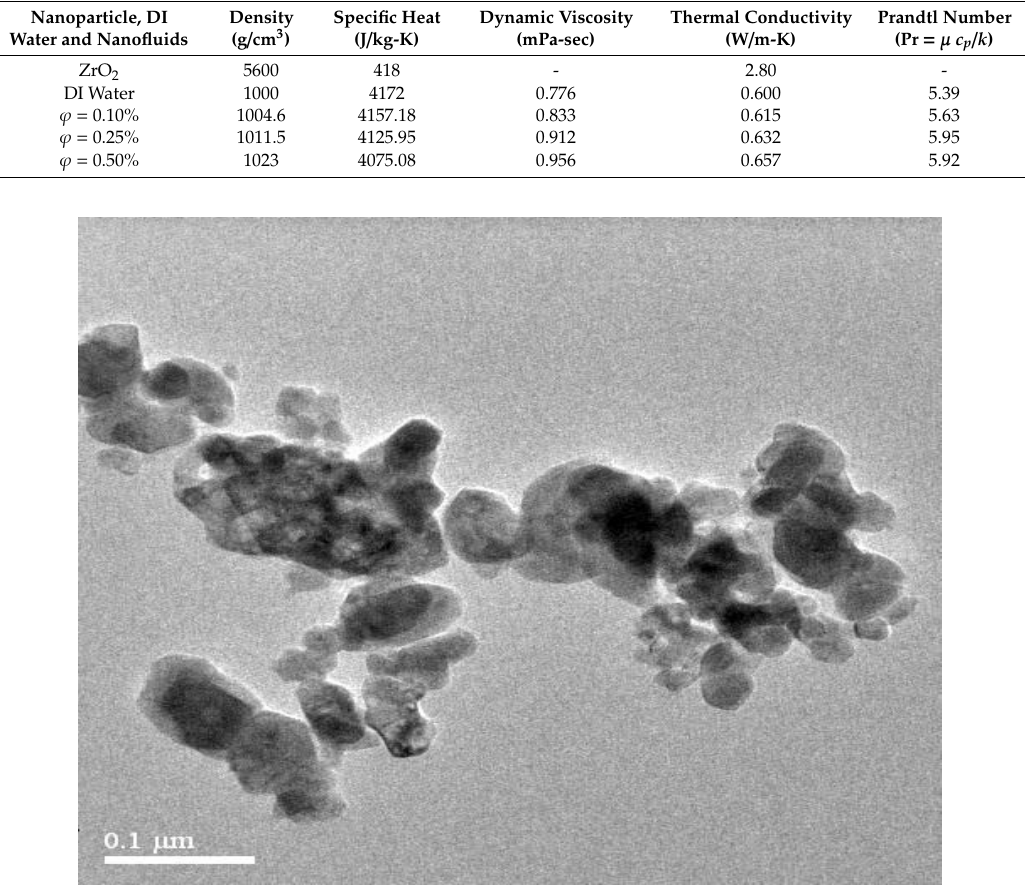
/ DI water nanofluid.